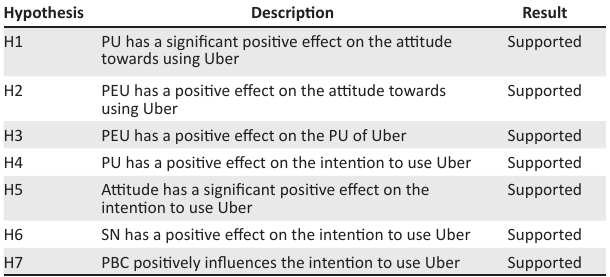
TABLE 5: Hypothesis testing. Model 1 – Technology Acceptance Model (TAM).